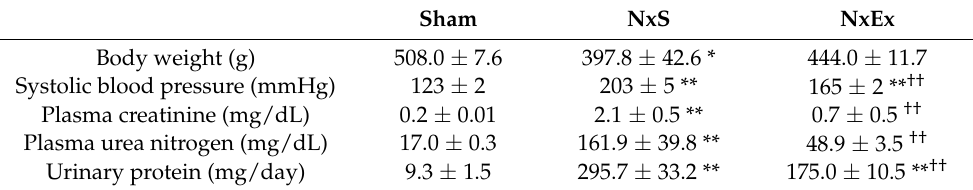
Table 1. Effects of exercise training on body weight, systolic blood pressure, and plasma and urinary